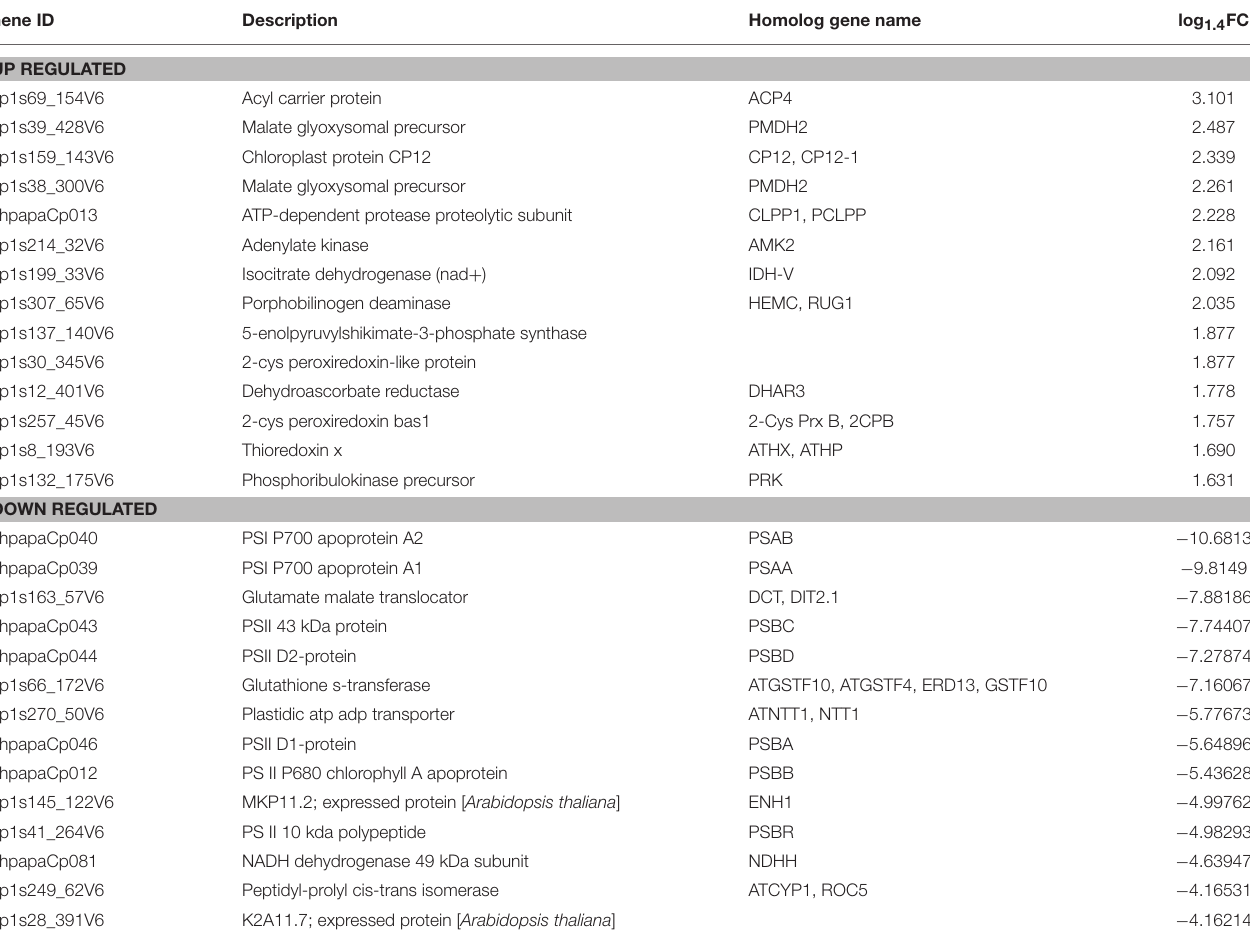
TABLE 1 | List of top 15 up- and down-regulated proteins in protoplasts. Gene ID